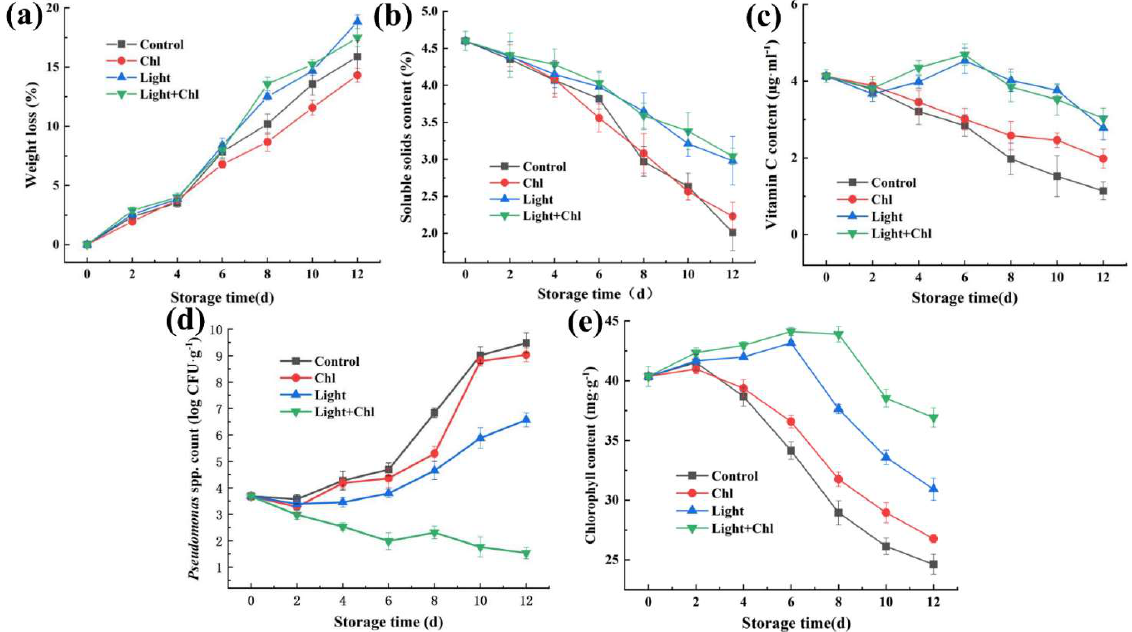
Figure 2. Changes in weight loss ( a ), soluble solids’ content ( b ), chlorophyll content ( c ), vitamin C content ( d ), and Pseudomonas spp. count ( e ) of samples with different treatments. Error bars represent the mean ± SE ( n = 3).